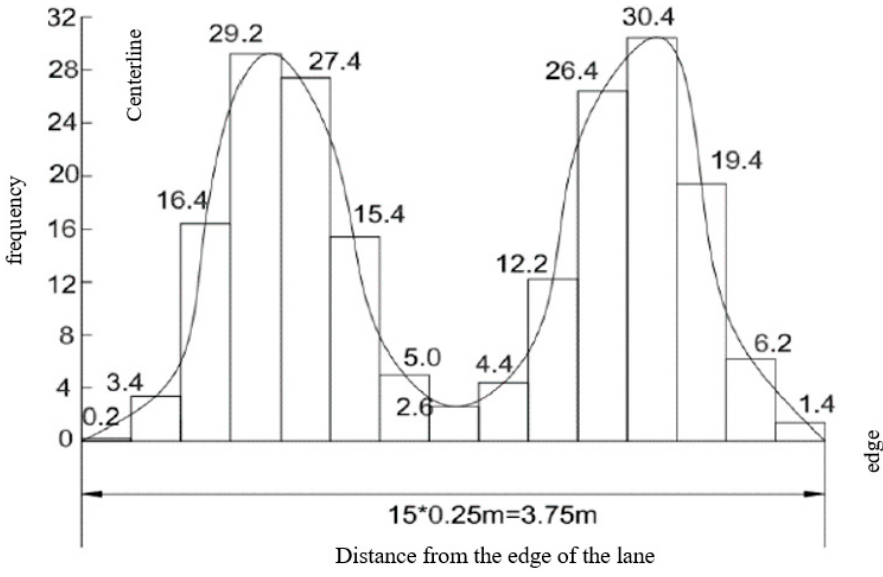
Figure 13. Wheel track transverse frequency distribution curve.